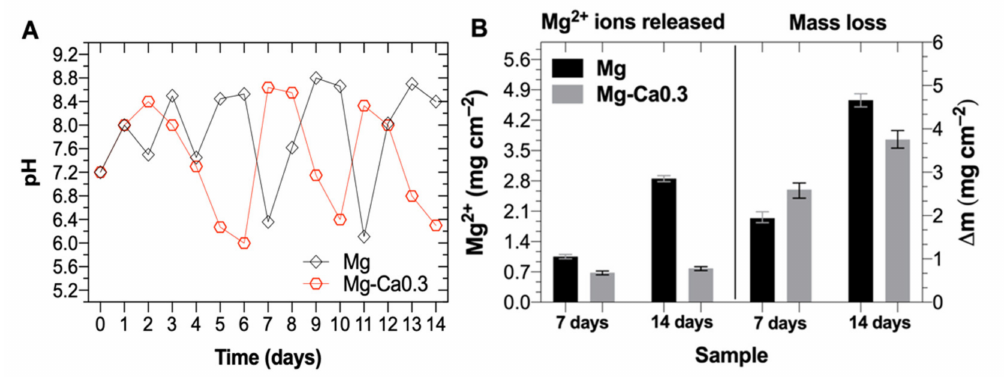
Figure 2. Changes in times of: ( A ) Hank’s solution pH up to 14 days during the exposure of Mg and Mg-Ca0.3 samples up to 14 days; ( B ) concentration of the released Mg 2+ ions and measured mass loss ( ∆ m) at 7 and 14 days. (Electrolyte renewal every 24